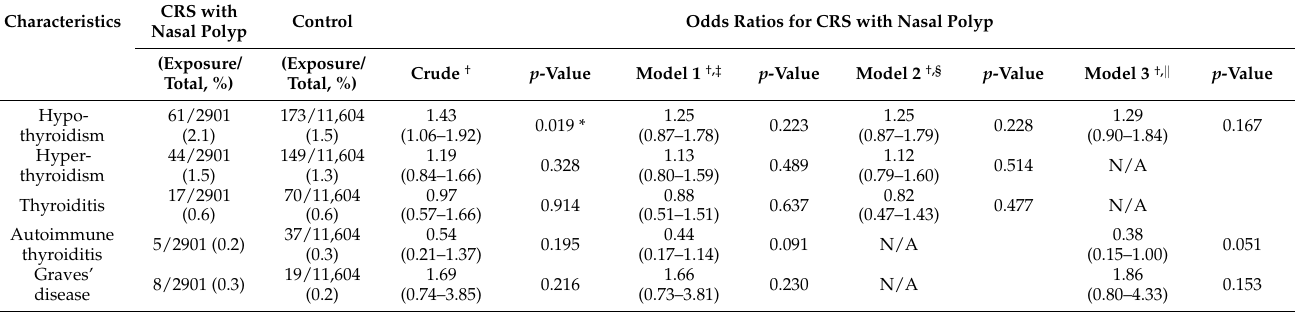
Table 3. Odds ratios (95% confidence interval) of each thyroid disease for total chronic rhinosinusitis with nasal